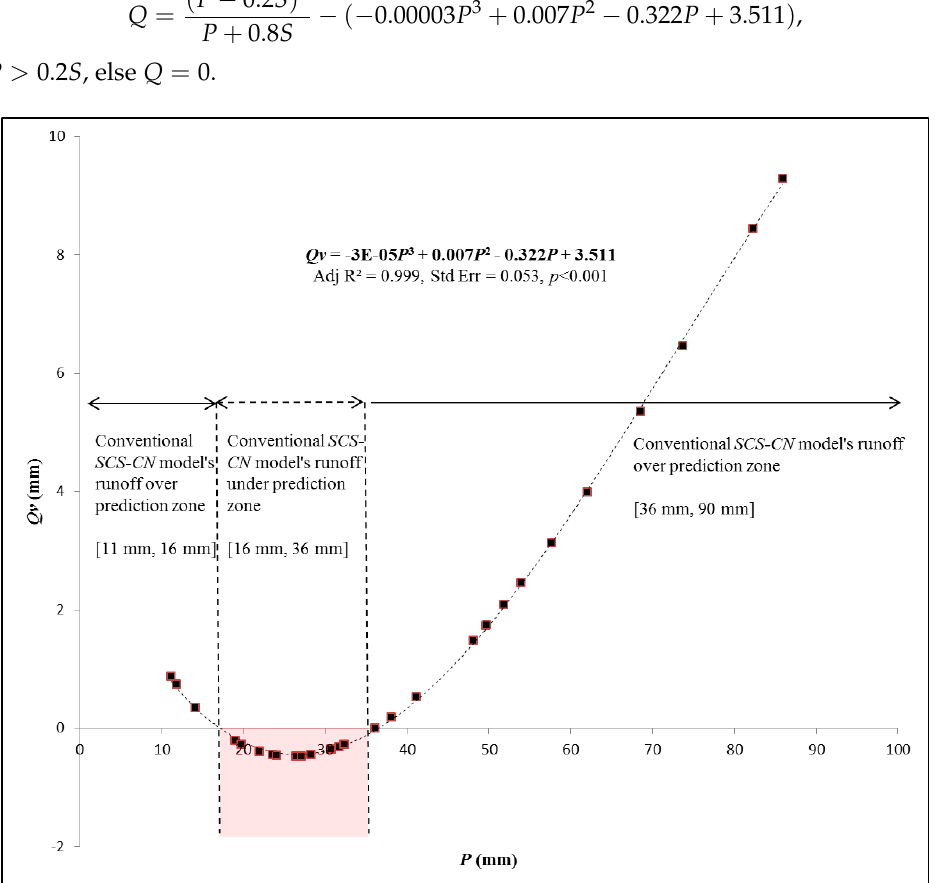
Figure 3. Runoff difference between the proposed calibrated model and the conventional SCS - CN